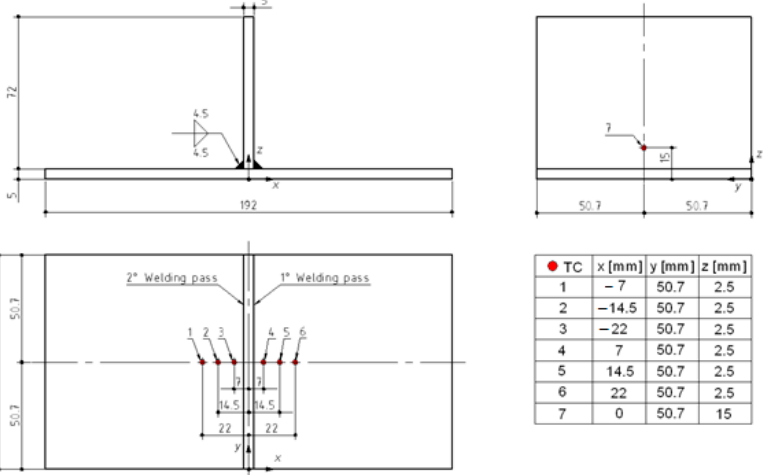
Figure 2. Plate dimensions and layout of thermocouples; “TC” stands for